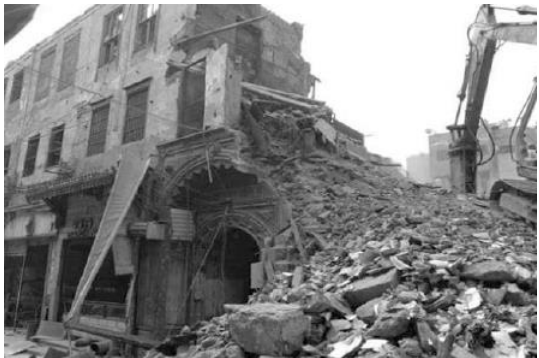
Figure 7. The façade of Wikāliẗ ạl - ’Anbariyin. (Source: Al-Ahram online article, 2016 http://www.ahram.org.eg/NewsQ/565296.aspx)